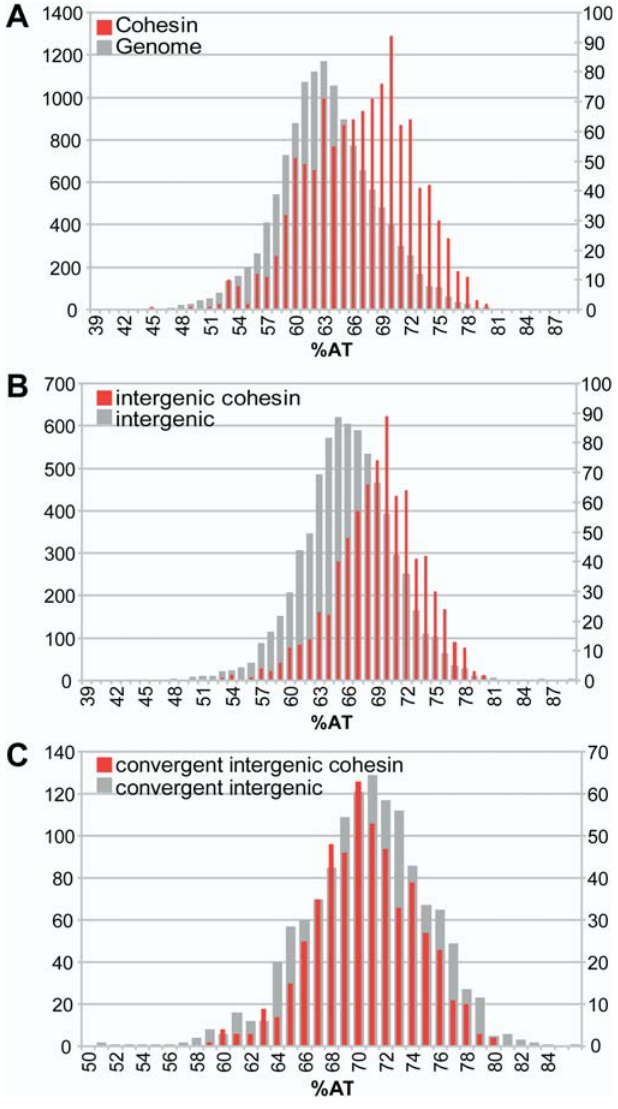
Figure 4. Peaks and AT Content (A) The AT content for each array element was calculated and put into bins in 1% intervals (grey bars, left y-axis). The AT content for each array element that is a cohesin peak was also put into bins (red bars, right y-axis). (B) The AT content for each intergenic array element was put into bins in 1% intervals (grey bars, left y-axis). The AT content for each intergenic array element that is a cohesin peak was also put into bins (red bars, right y-axis). (C) The AT content for each convergent intergenic array element was put into bins (grey bars, left y-axis) and the AT content for each convergent intergenic array element that is a cohesin peak was also put into bins (red bars, right y-axis). DOI: